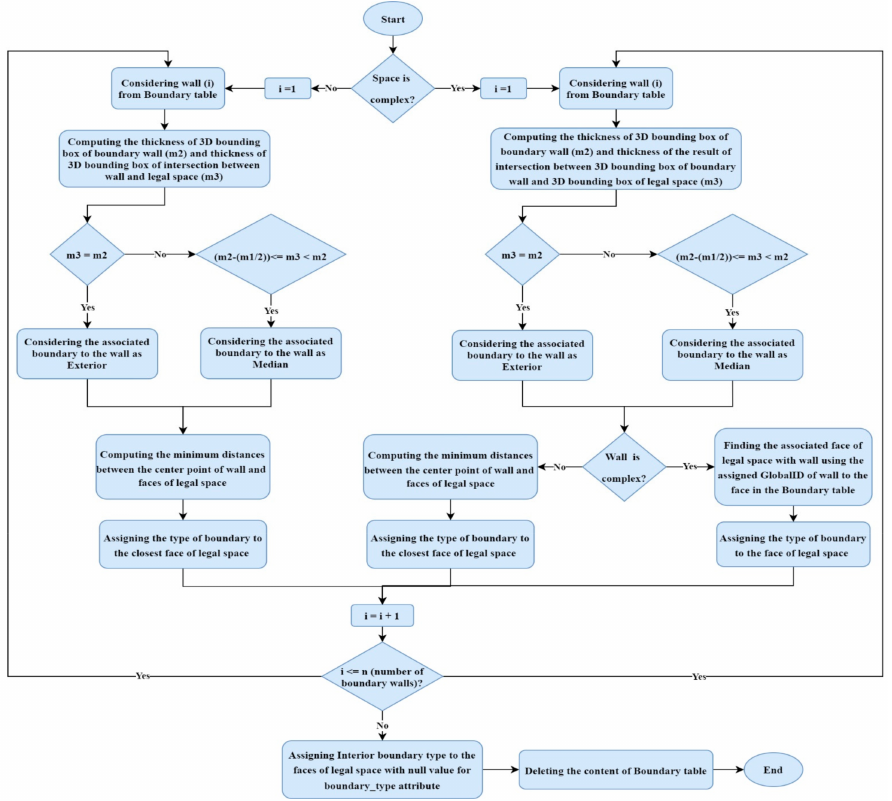
Figure 16. A methodology for detecting different types of property boundaries associated with walls.